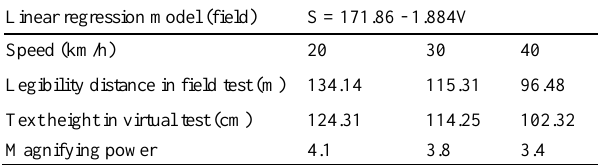
Fig.9. Text height and legibility distance relationship